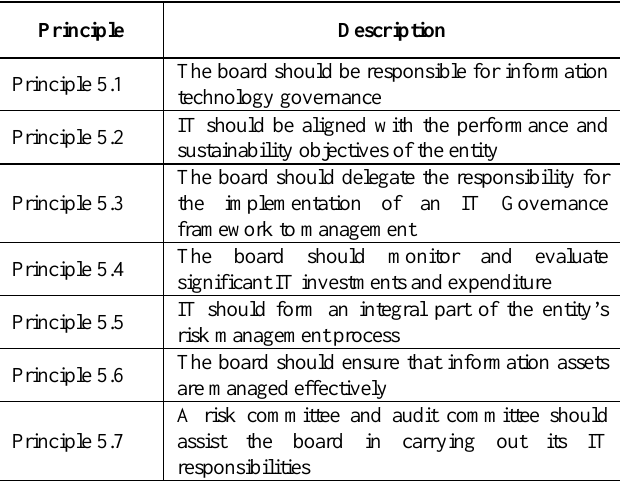
Table 1: Seven IT Governance principles of King